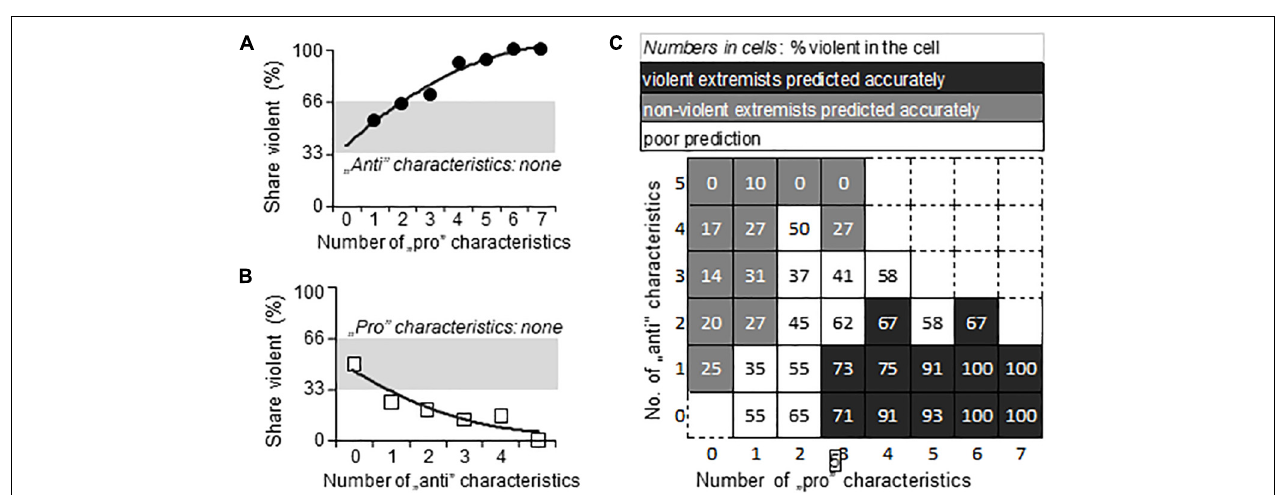
FIGURE 3 | The prediction of violence by the number of pro- and anti-violence characteristics. (A,B) The dependence of the share of violent individuals on the number of pro-violence (“pro”) and anti-violence (“anti”) characteristics, respectively, when the opposite characteristic was not present in the individual. (C) The interactive dependence of violence on the relation between the number of pro-violence and anti-violence characteristics present in the individual. Gray, the area of chance prediction (34–66%, i.e., close to 50%).